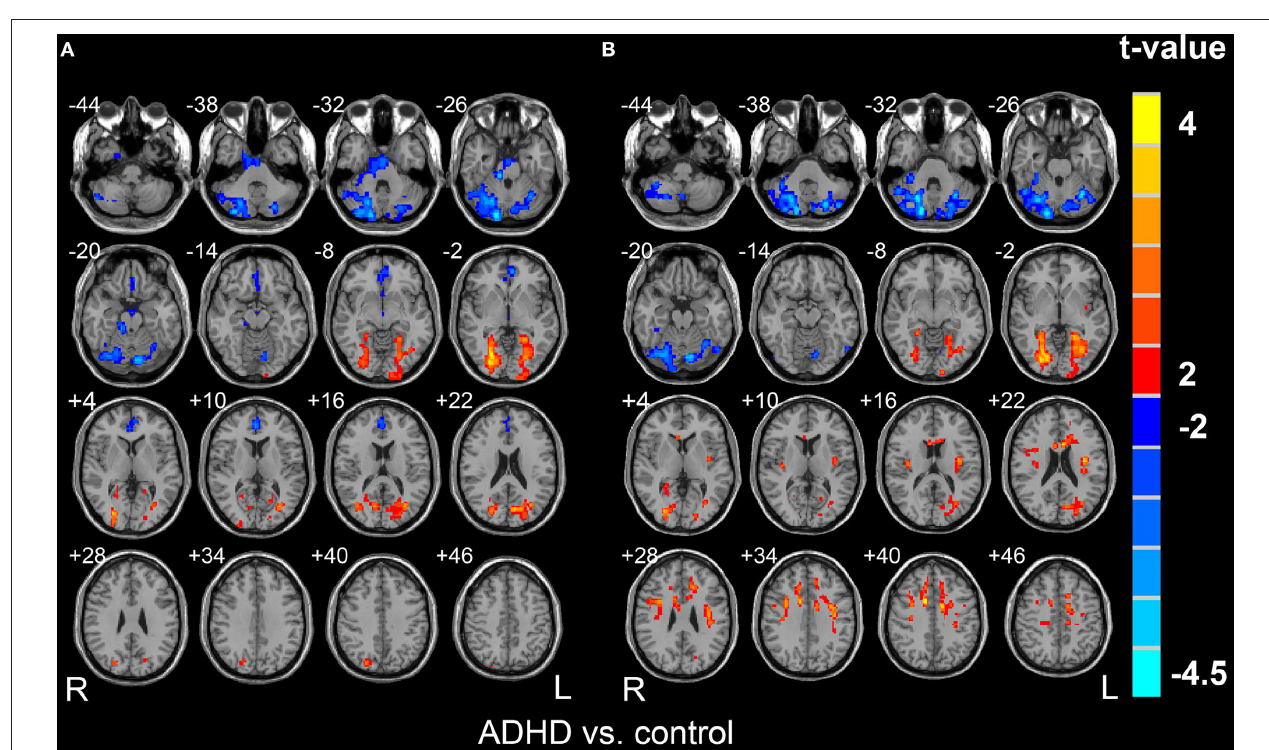
FIguRe 6 | Brain regions showing significantly different Cohe-ReHo (A) and KCC-ReHo (B) between ADHD group and control group ( p < 0.05, corrected). The left side of the image corresponds to the right side of